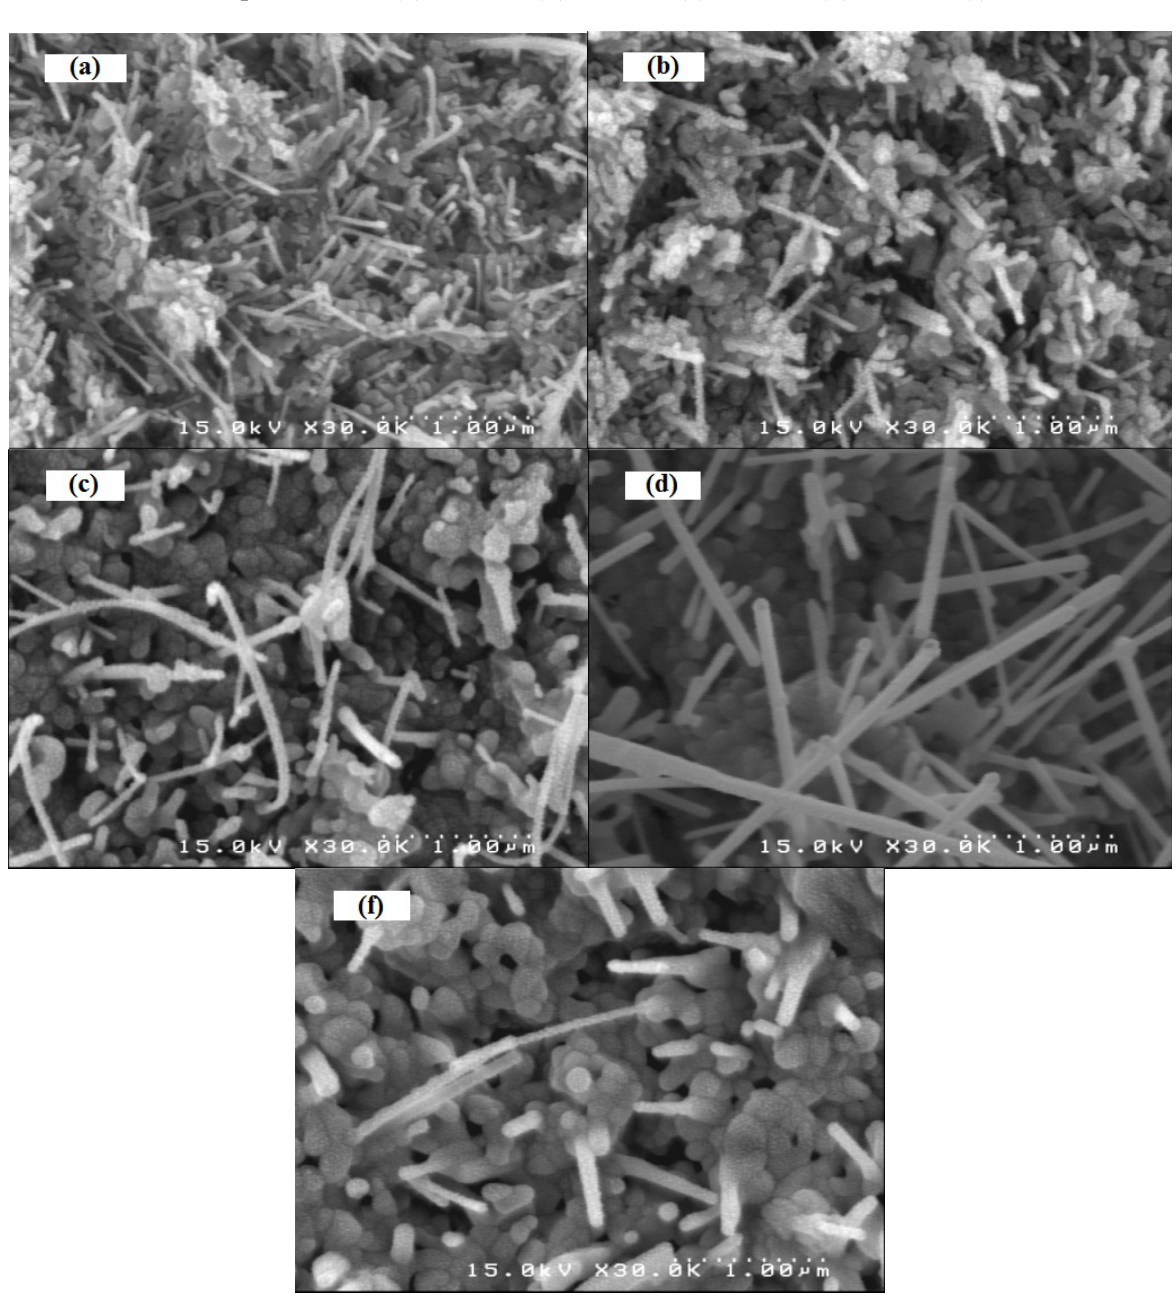
Figure 2. SEM images of the ZnO nanowires prepared by the oxidation of Zn thin films